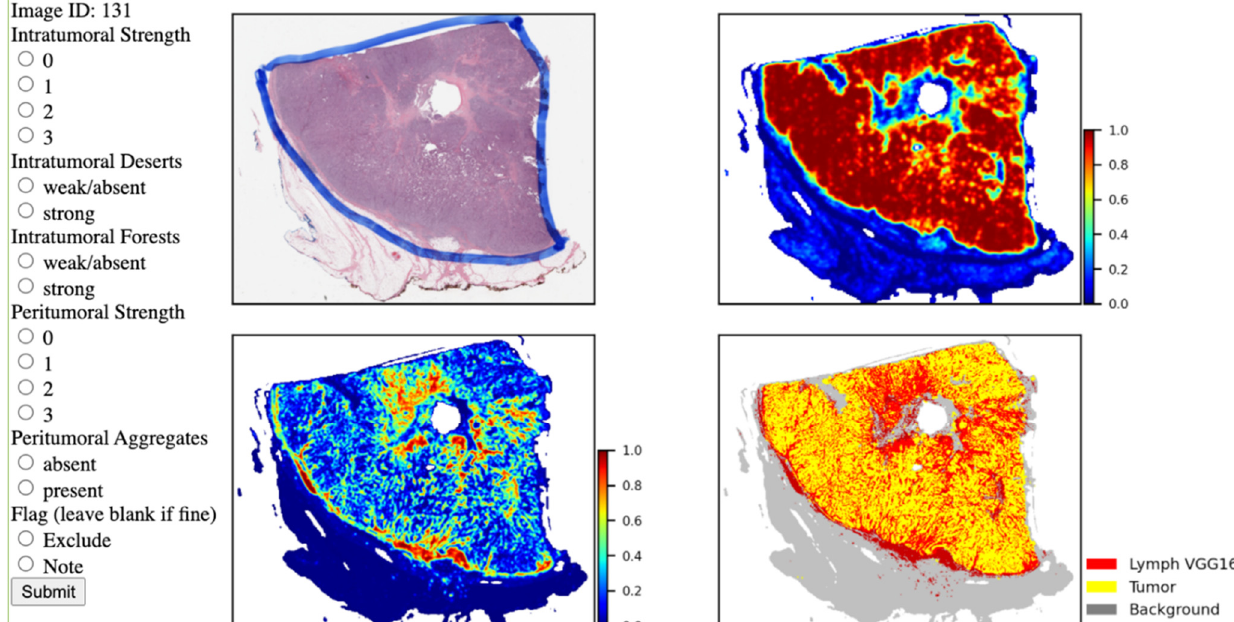
Figure 2. Scoring interface to characterize spatial features of TIL infiltrates in breast cancer. Composite Tumor-TIL maps of H&E WSIs of breast cancer provide the ability to estimate the abundance and spatial distribution of TILs in a straightforward manner. Tumor-TIL maps are depicted as 4-panel composites containing low-resolution H&E WSI (upper left), tumor probability heatmap (upper right), lymphocyte probability heatmap (lower left), and the Tumor-TIL map (bottom right). Tumor and lymphocyte probability maps use a color scale to indicate probability from 0 (blue) to 1 (red). In the Tumor-TIL map, yellow represents tumor, red depicts lymphocytes, and non-tumor/non-lymphocyte patches are represented as gray background tissue. Observers use this interface to characterize the magnitude of intratumoral and peritumoral TIL infiltrates on a scale of 0 (none/absent) to 3 (marked). The presence of large intratumoral aggregates (forests), immune cold areas devoid of TILs (deserts), and tertiary lymphoid aggregates are indicated on the left panel. In this example, case 131, intratumoral strength was graded as 3 with weak/absent deserts and strong forests, peritumoral strength was graded as 3, and tertiary peritumoral aggregates as absent. Poor quality images and cases where the algorithms did not properly generate a Tumor-TIL map were flagged and excluded.